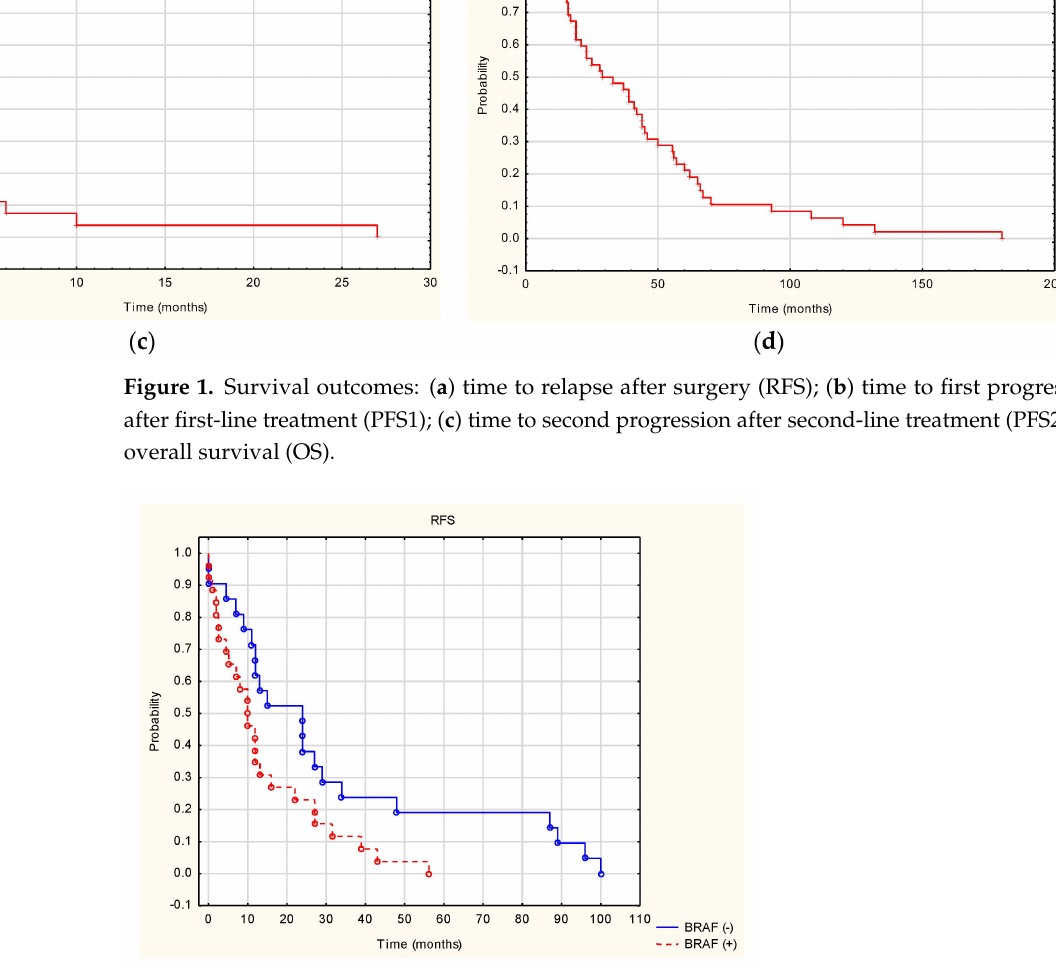
Figure 2. Time to relapse after surgery (RFS) in patients BRAF V600 (+) and wild-BRAF ( − ). Table 2. The influence of variables on survival